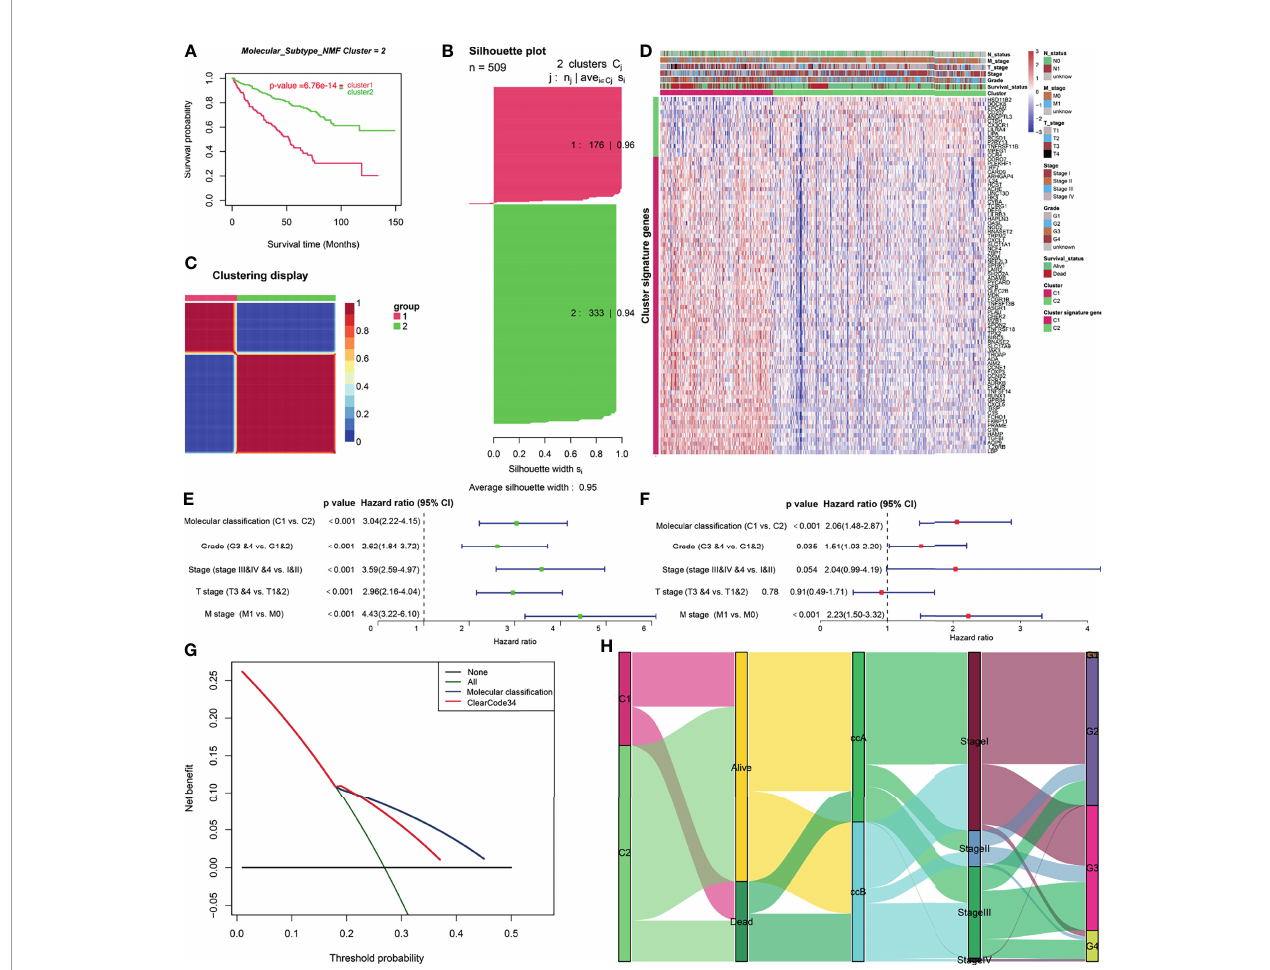
FIGURE 3 | Construction and clinical signi fi cance analysis of molecular classi fi cation in TCGA cohort. (A) Kaplan-Meier analysis showed the Cluster1 patients had signi fi cantly poorer prognosis than Cluster2 patients. (B) Silhouette coef fi cients near 1 indicate that the sample is distinguished from neighboring clusters and determine that the best number of clusters was two. (C) Differential expression tested the expression difference between two clusters. (D) Heatmap of the speci fi c cluster-associated genes. Forrest plot of univariate (E) and multivariate (F) Cox regression analysis in the TCGA cohort. (G) DCA for 5-year OS prediction shows that the molecular cluster (Cluster) has higher net bene fi t across 0% to 50% threshold probabilities than ClearCode34 classi fi cation (Classi fi cation). (H) A Sankey plot was used to reveal the correlation between molecular cluster, ClearCode34 classi fi cation, and clinical characteristics. (DCA, decision curve analysis; TCGA, The Cancer Genome Atlas; OS, overall